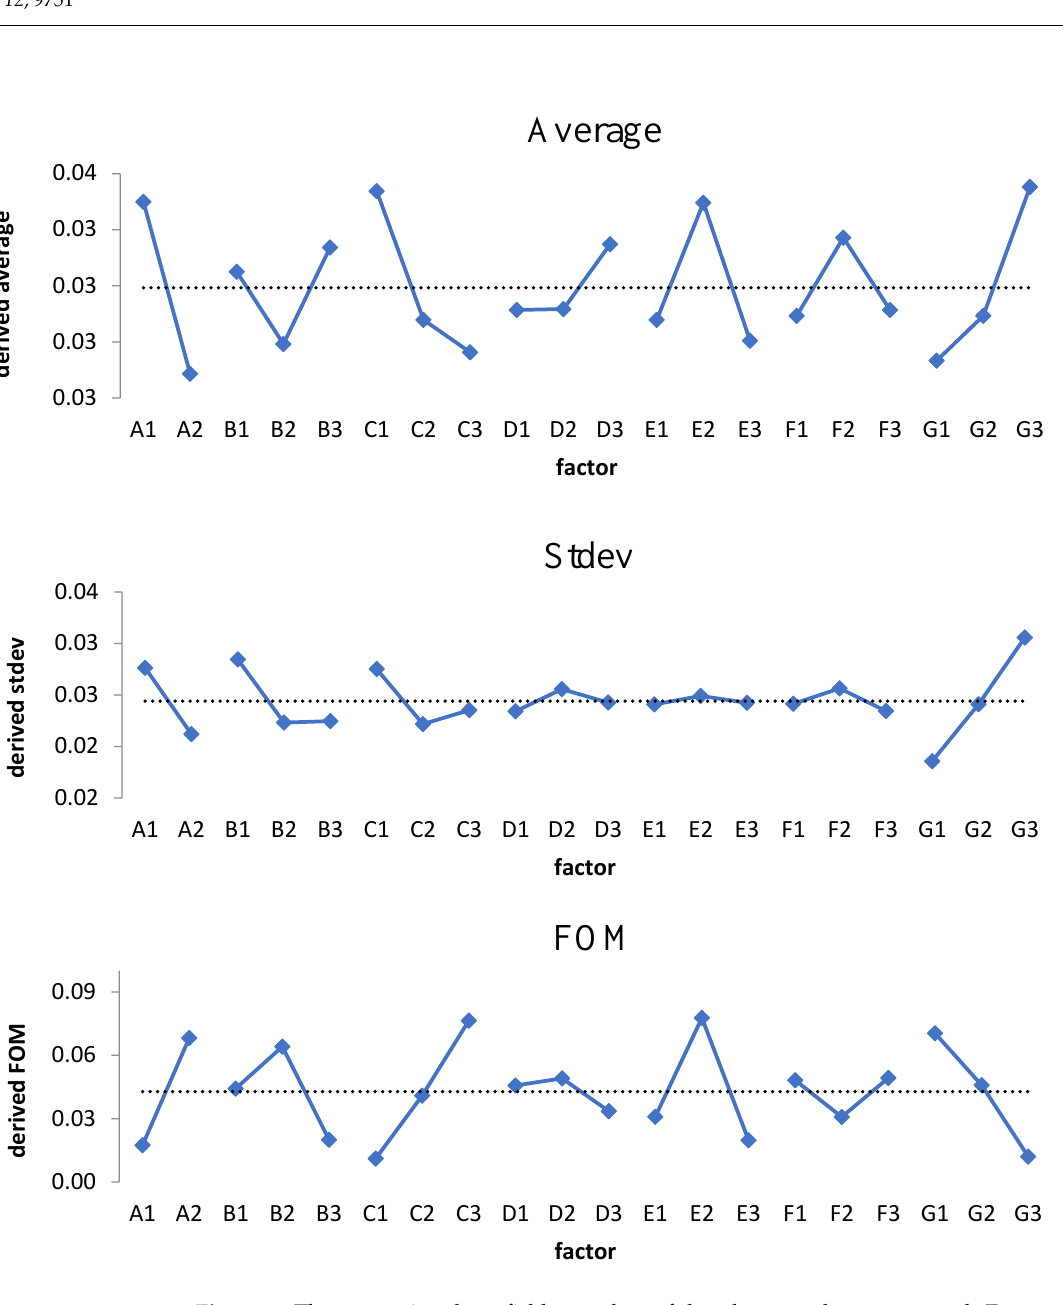
Figure 3. The respective three fishbone plots of the ultrasound scan protocol. Factors A (angle of probe), B (signal gain), C (resolution vs. speed), E (XRES), and G (time gain compensation) have the dominant contribution among all factors (cf. Table 3).